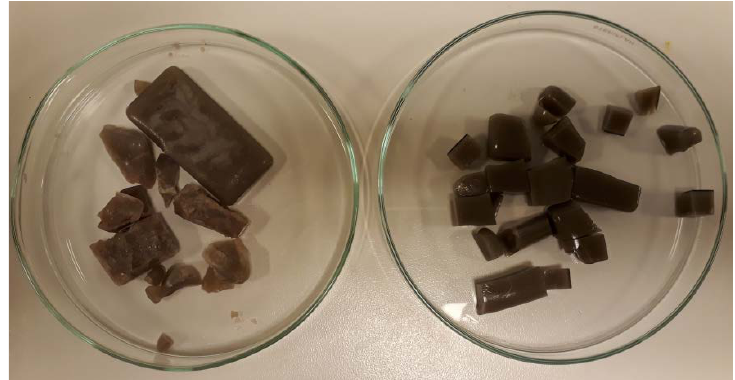
Fig. 3 Non-transparent samples containing 80KPO3-20Slag and 70KPO3-30Slag, respectively.